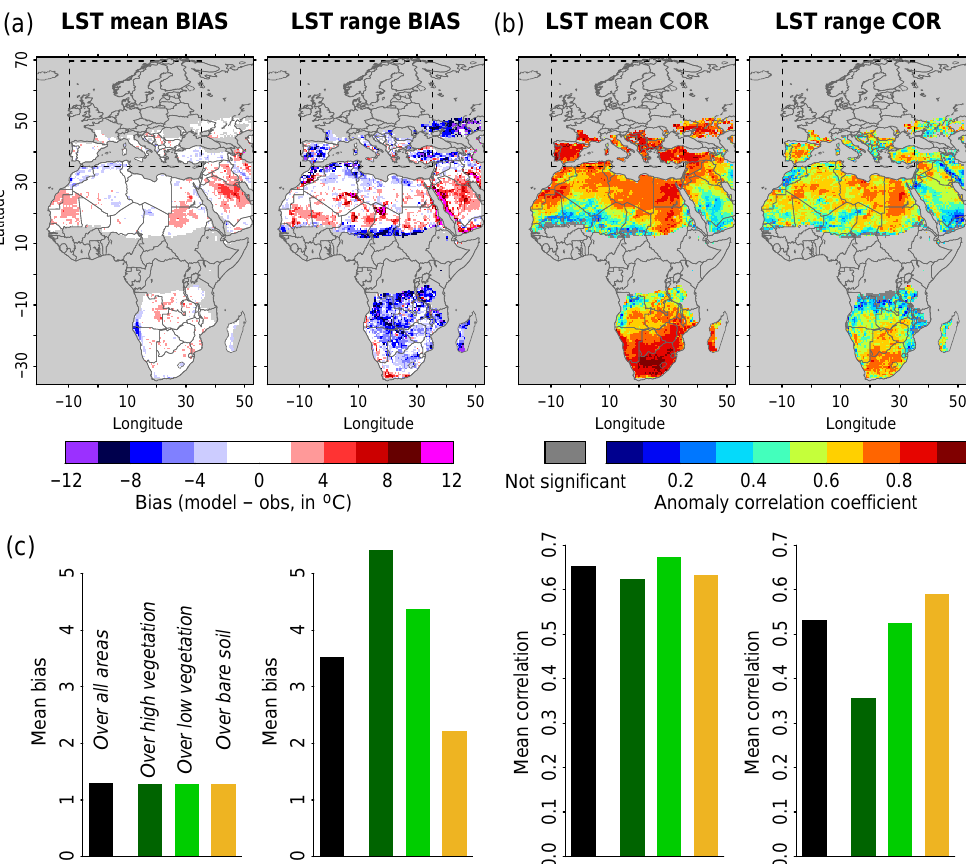
Figure 1. Evaluation of HTESSEL against LST data. We consider biases (a) and daily anomaly correlation (b) of mean daily LSTs and of the daily LST range. The dark grey colour indicates correlations which are not significantly different from zero. The light grey colour denotes oceans and areas where no data are available. Bar plots (c) summarize results for all vegetation types, and for particular vegetation types only. The dashed rectangle in the top plots denotes the European area which most of this study is based